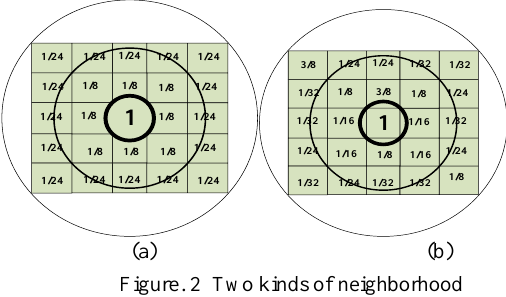
Figure. 2 Two kinds of neighborhood